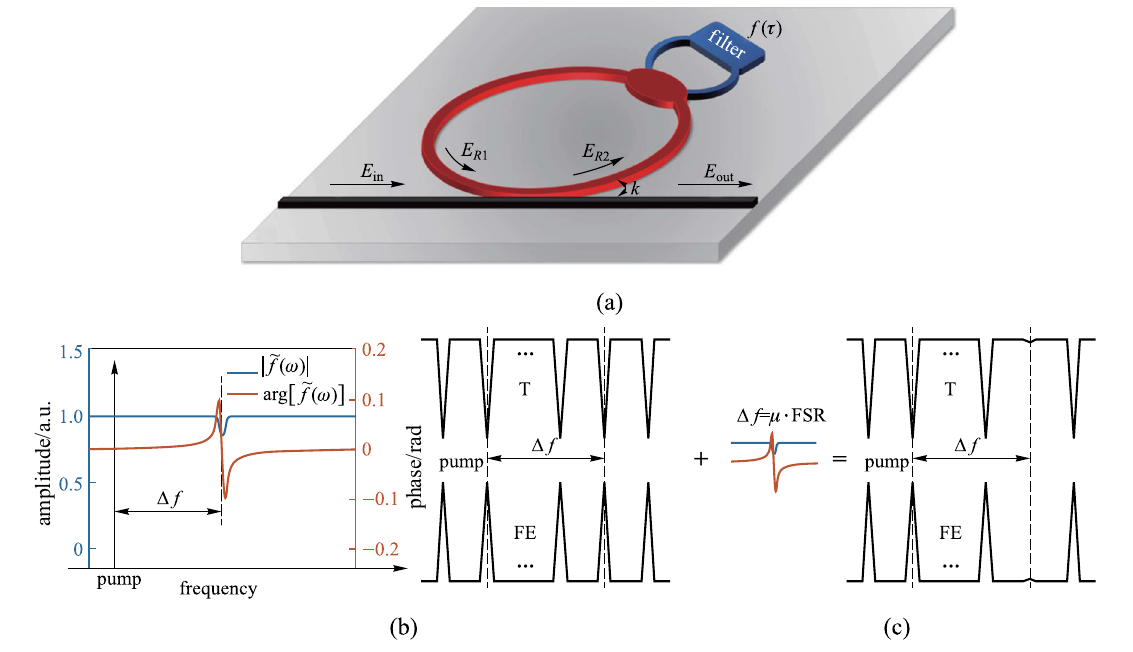
Fig. 1 Schematic diagram of the proposed selective SMD system. a Device structure. A filter (blue) is coupled to a micro-ring resonator (red). E E in and out are the input and the output electric fields. E = a e i 𝜙 E R 1 R 2 . b Amplitude response of FSR. c Schematic diagram of the change of T and FE before and after introducing the selective